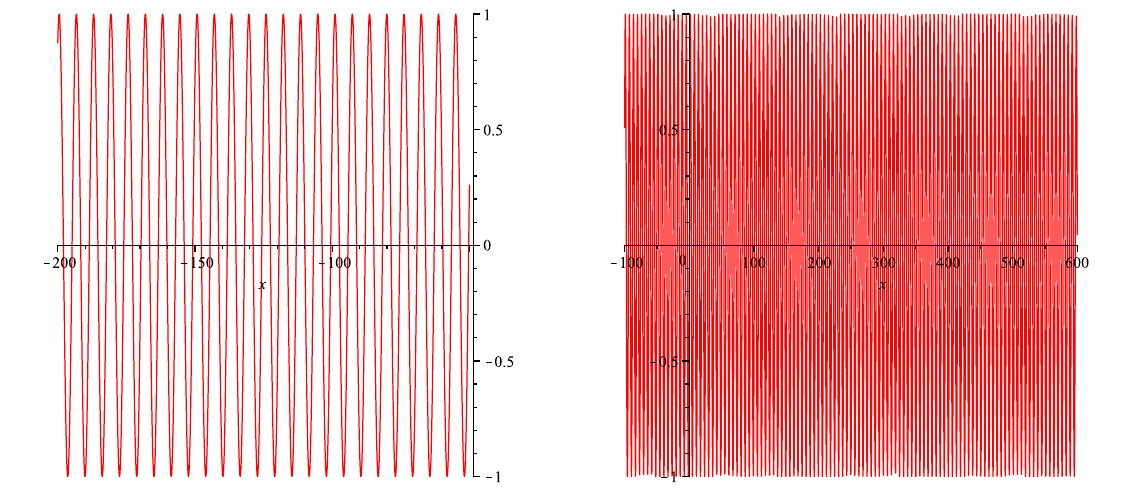
Figure 1. The graphs of f with: r = 150 ( left ); and r = 500 ( right